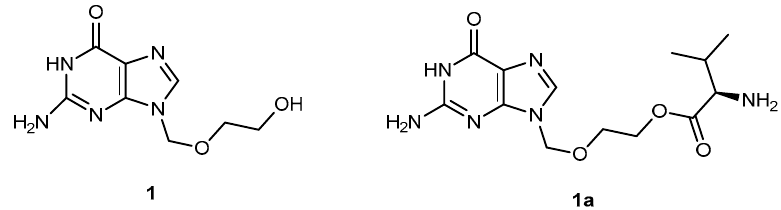
Figure 2. Chemical structures of ACV ( 1 ) and the amino acid prodrug valacyclovir ( 1a ).